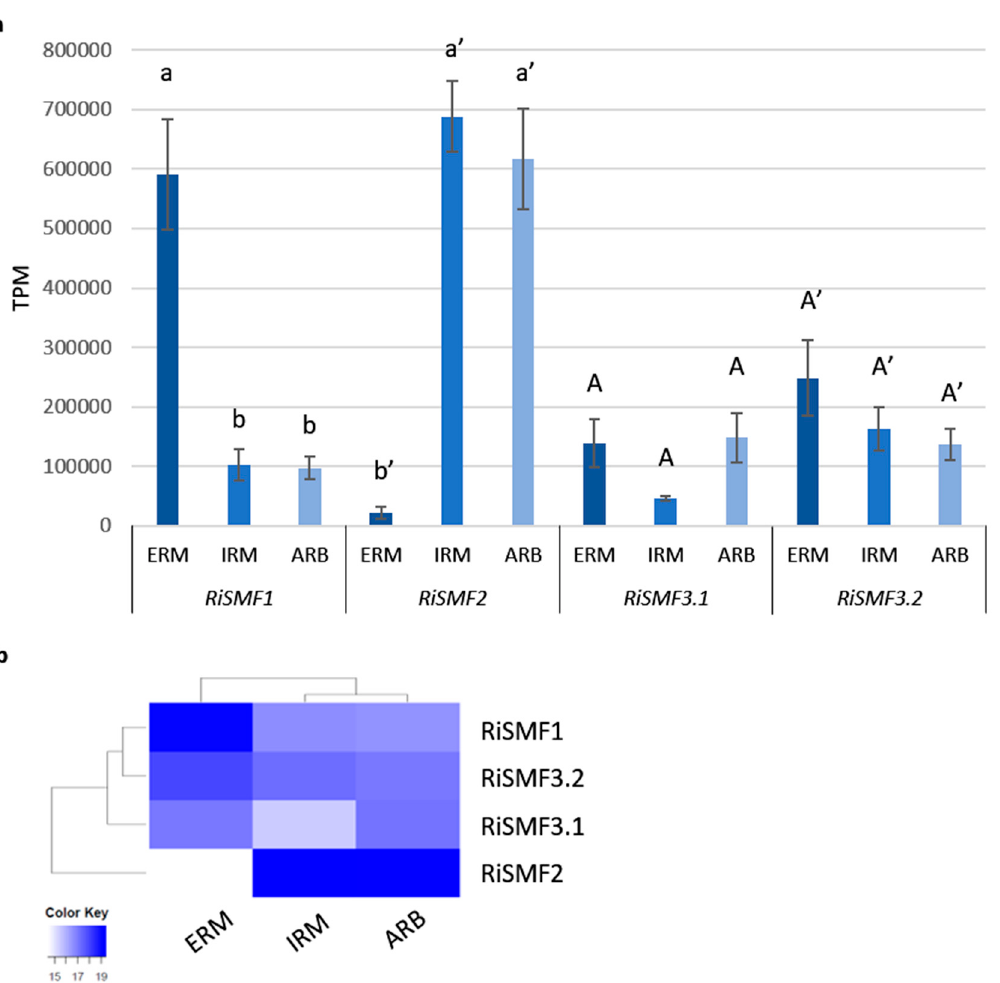
Figure 4. Expression patterns of R. irregularis SMF genes. ( a ) RiSMF s expression, based on RNAseq analyses of ERM grown in monoxenic cultures as well as IRM and arbucules (ARB) collected by laser microdissection, from Medicago truncatula mycorrhizal roots. Error bars represent SE from three biological replicates. Different letters indicate significant differences ( p < 0.05). ( b ) Heatmap showing the hierarchical clustering of SMF genes, grouped according to the expression patterns in ERM, IRM and ARB. Gradient color ranging from white to bright blue corresponds to expression values log2 transformed.